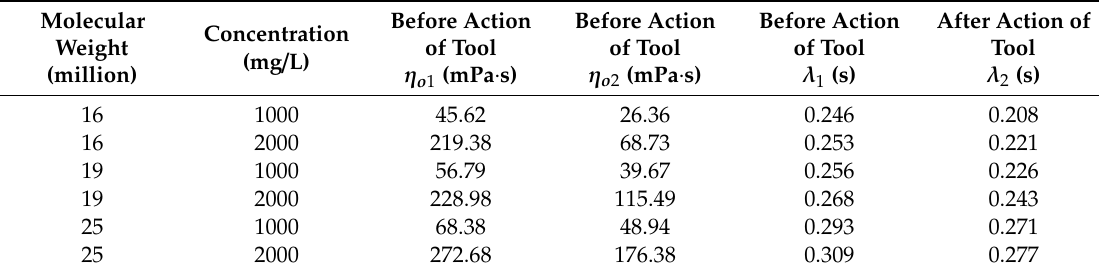
Table 5. Relaxation time and zero shear viscosity of alkali / surfactant / polymer (ASP) solution before and after flowing through the di ff erent medium tool in dynamic